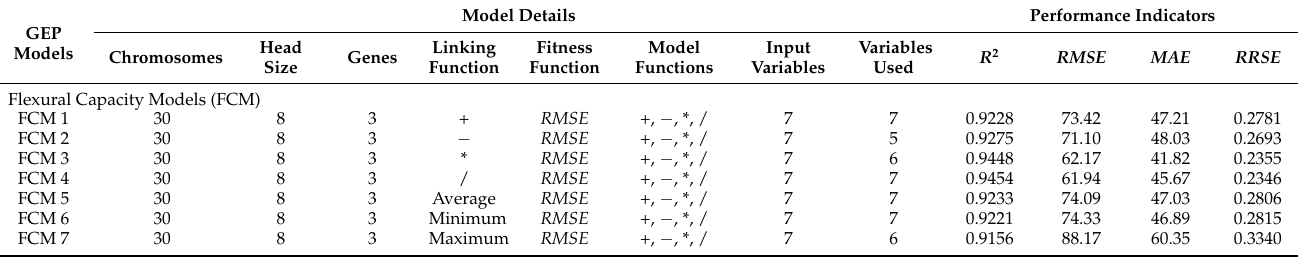
Table 4. Summary of GEP Models for Predicting the Bearing Capacity of RC Rectangular